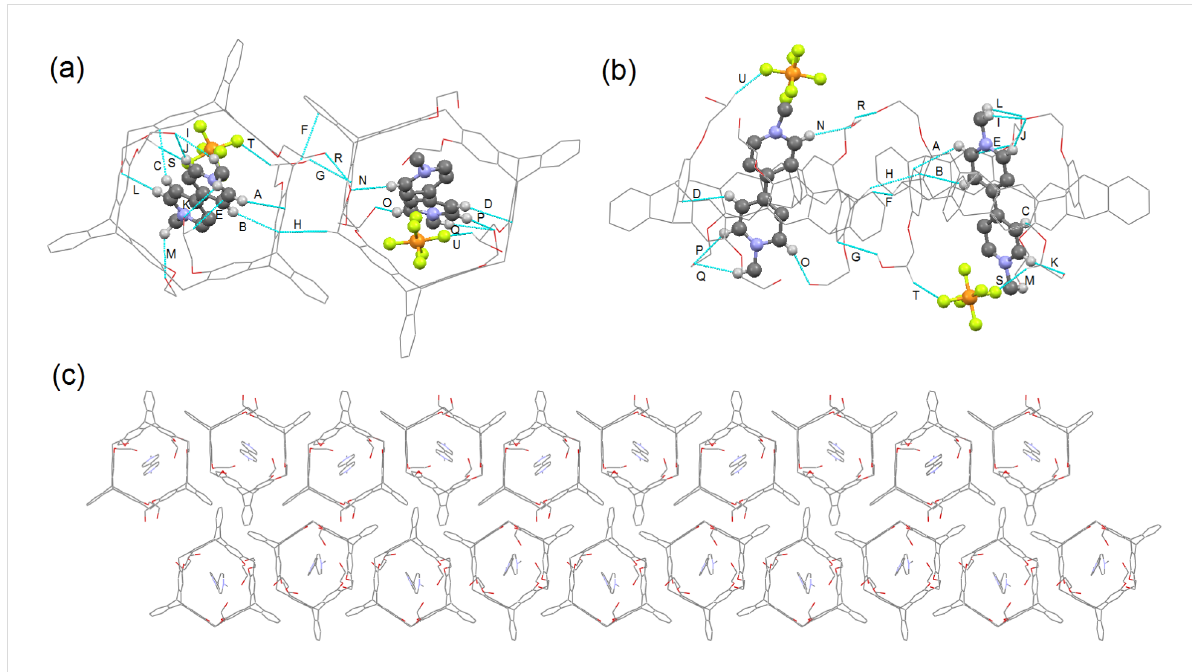
Figure 5: Crystal structure of complex H5·G1 . (a) Top view, (b) side view, and (c) packing viewed along the a- axis. Blue lines denote the non-cova- lent interactions between H5 and G1 . Solvent molecules, PF 6 − counteranions and hydrogen atoms not involved in the non-covalent interactions were omitted for clarity.